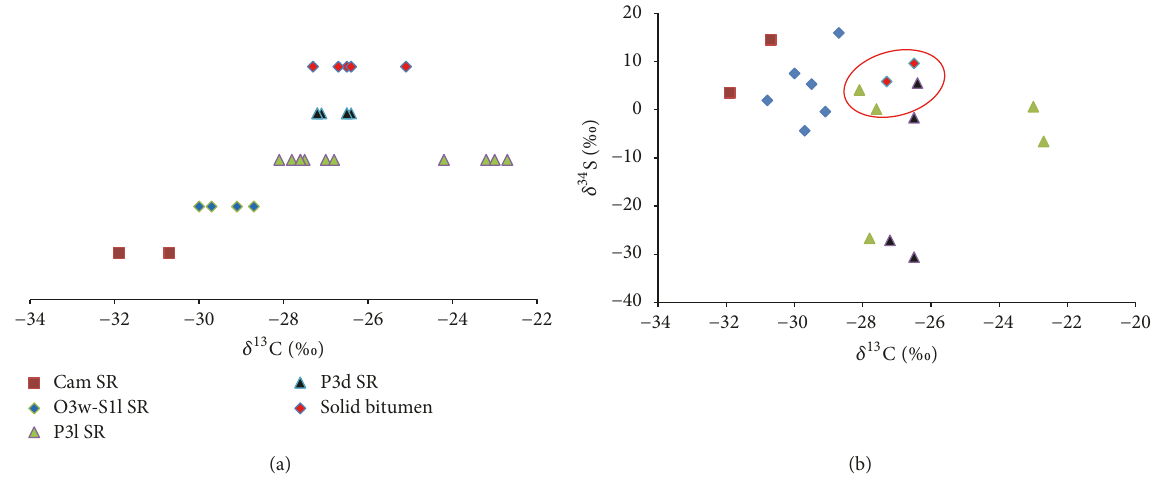
Figure 6: (a) Comparison of 𝛿 13 C values and (b) cross-plot of 𝛿 13 C and 𝛿 34 S values, from non-TSR altered solid bitumen and different source rocks. Note: SR is source rock in short.